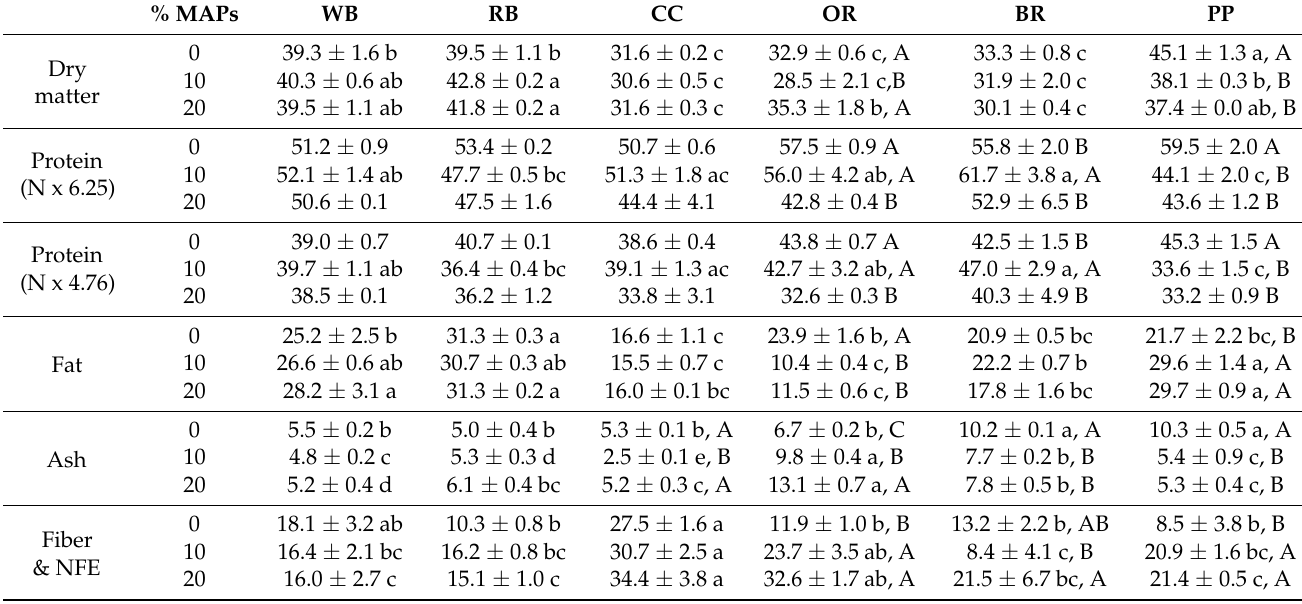
Table 3. Proximate composition of Tenebrio molitor larvae fed agri-food industry by-products supple- mented with 0, 10% or 20% distillation residues of Medicinal Aromatic Plants